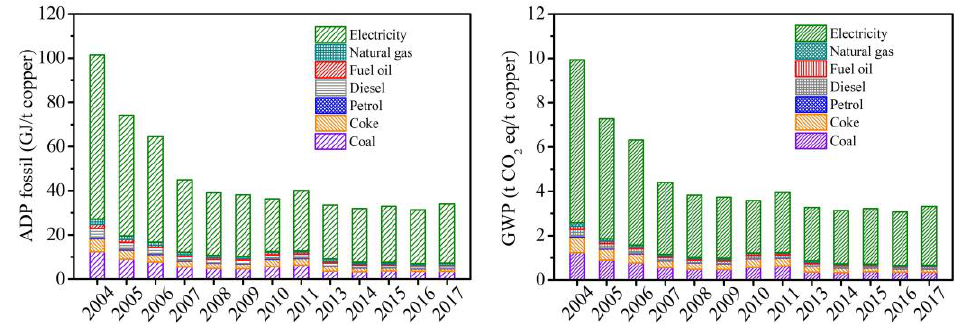
Figure 4. Contribution of different energy consumption to the ADP fossil and GWP from 2004 to 2017.